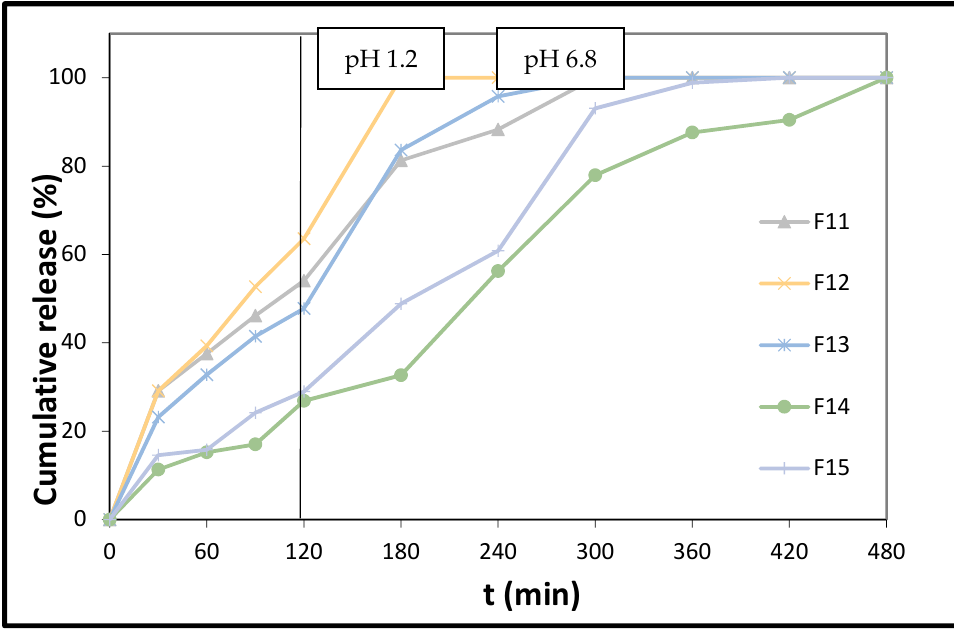
Figure 7. In vitro % release of melatonin from formulations F11, F12, F13, F14, and F15 vs. time. The results represent the mean value (n = 3, SD < 2).